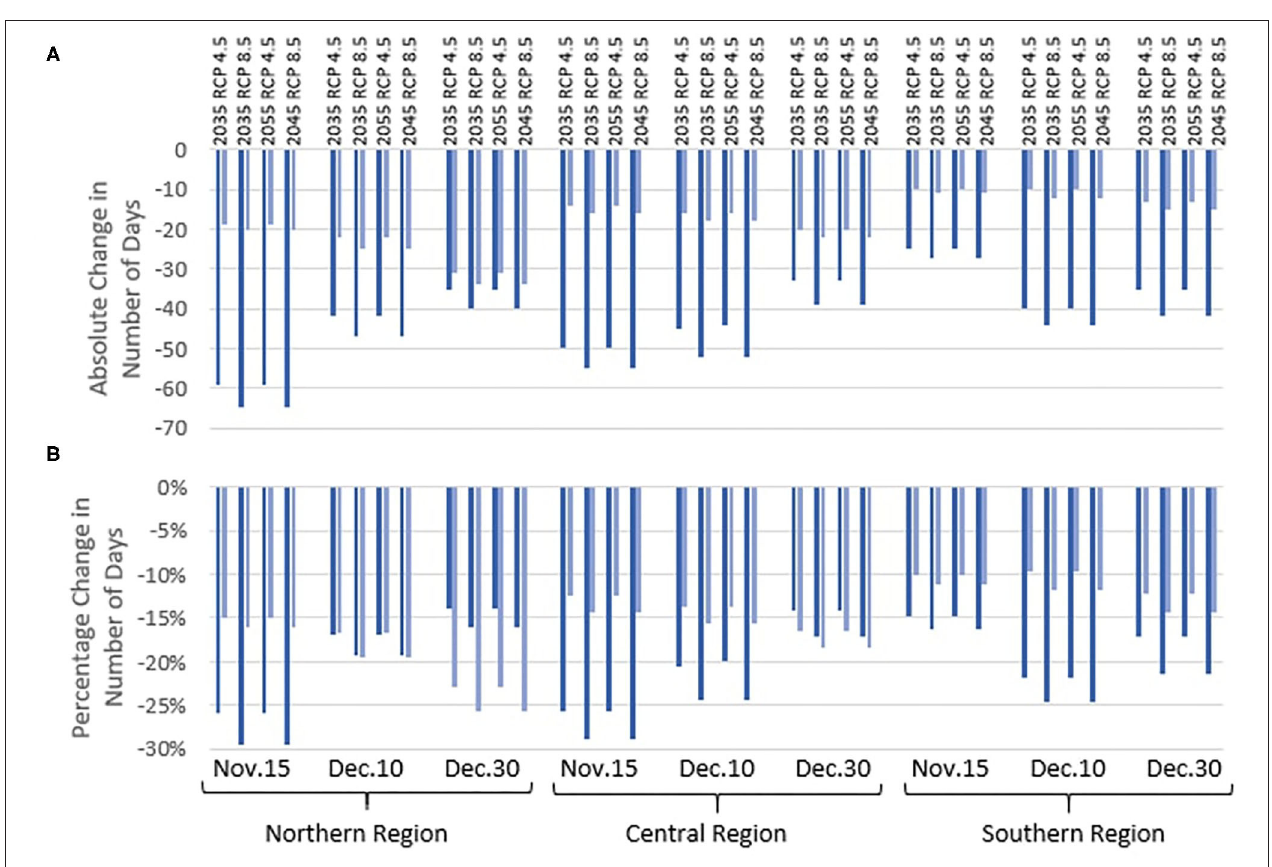
FIGURE 2 | Absolute (A) and relative (B) change in the number of days between sowing date and harvest date for two maize varieties planted on three different sowing dates (November 15, December 10, and December 30) in the three Malawi regions (Northern, Central, and Southern). These data are provided for two future time periods (2020–2049 and 2040–2069) and Representative Concentration Pathways (RCPs) (4.5 and 8.5) and are compared to the baseline period